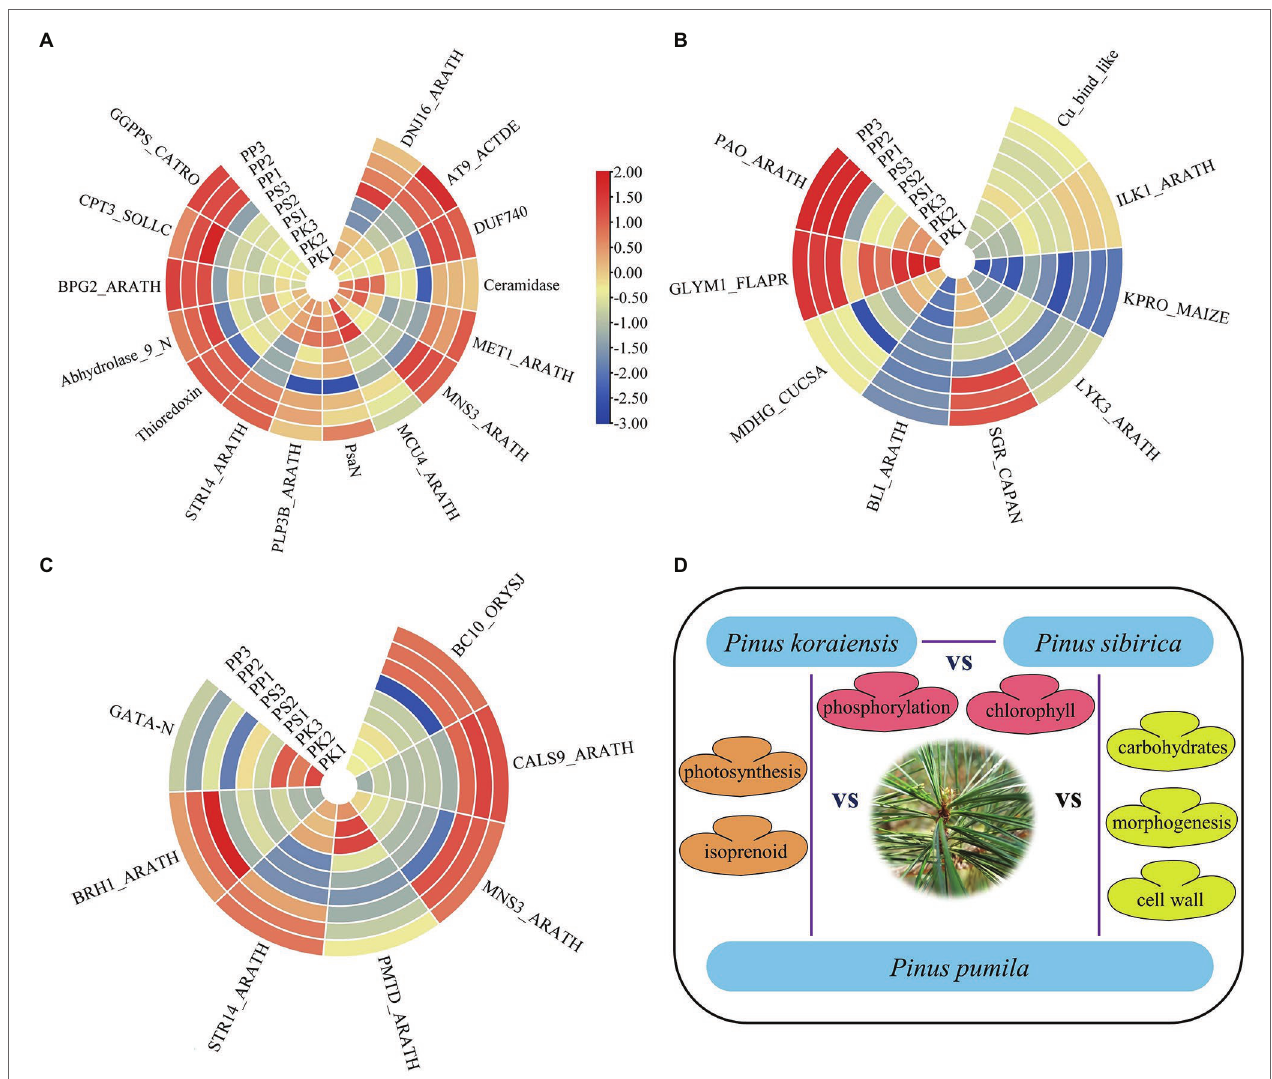
FIGURE 7 | The expression heatmap of DEGs enriched in the first four GO terms. (A) The heatmap of enriched DEGs in PK_vs_PP. (B) The heatmap of enriched DEGs in PK_vs_PS. (C) The heatmap of enriched DEGs in PS_vs_PP. (D) Schematic diagram of the mechanism of needle